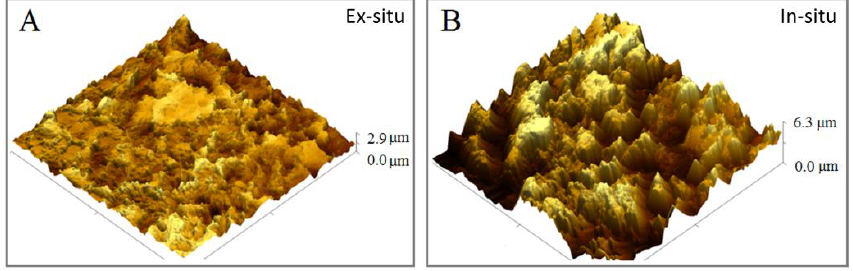
Figure 5. Three-dimensional AFM images of the copper surface corroded in HCl for after 24 h. ( A ) × 40 µ m 2 . B = 0 and ( B ) B > 0. The scan area is 40 × 40 µm 2 . ( A ) B = 0 and ( B ) B > 0. The scan area is 40